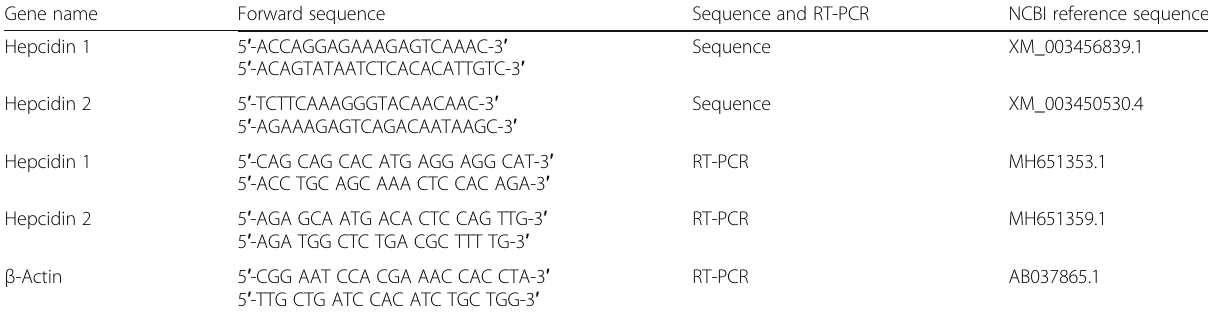
Table 1 The designed primer sequences used for PCR amplification and RT-PCR in tilapia